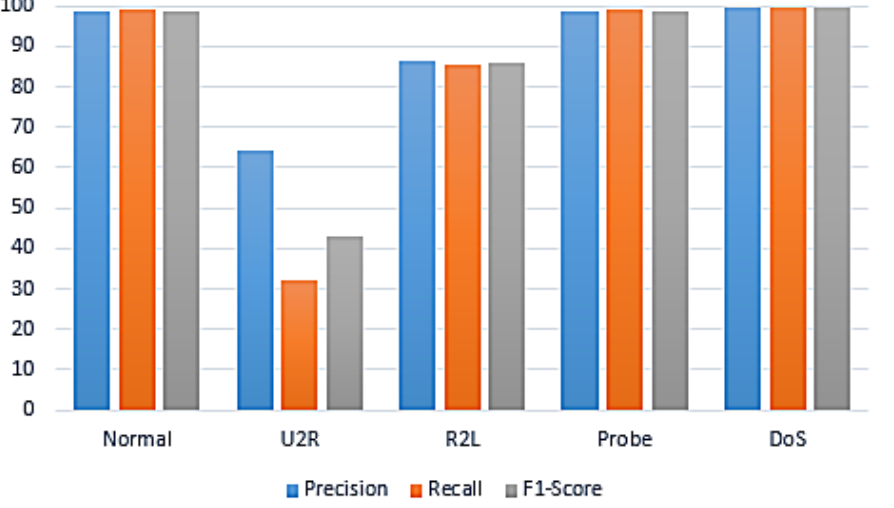
Figure 6. Classification report of random forest.